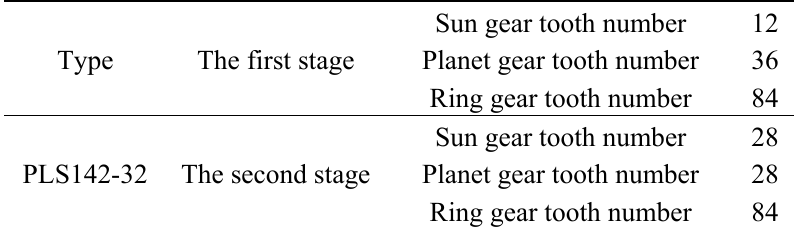
Table 2. The parameters of the planetary